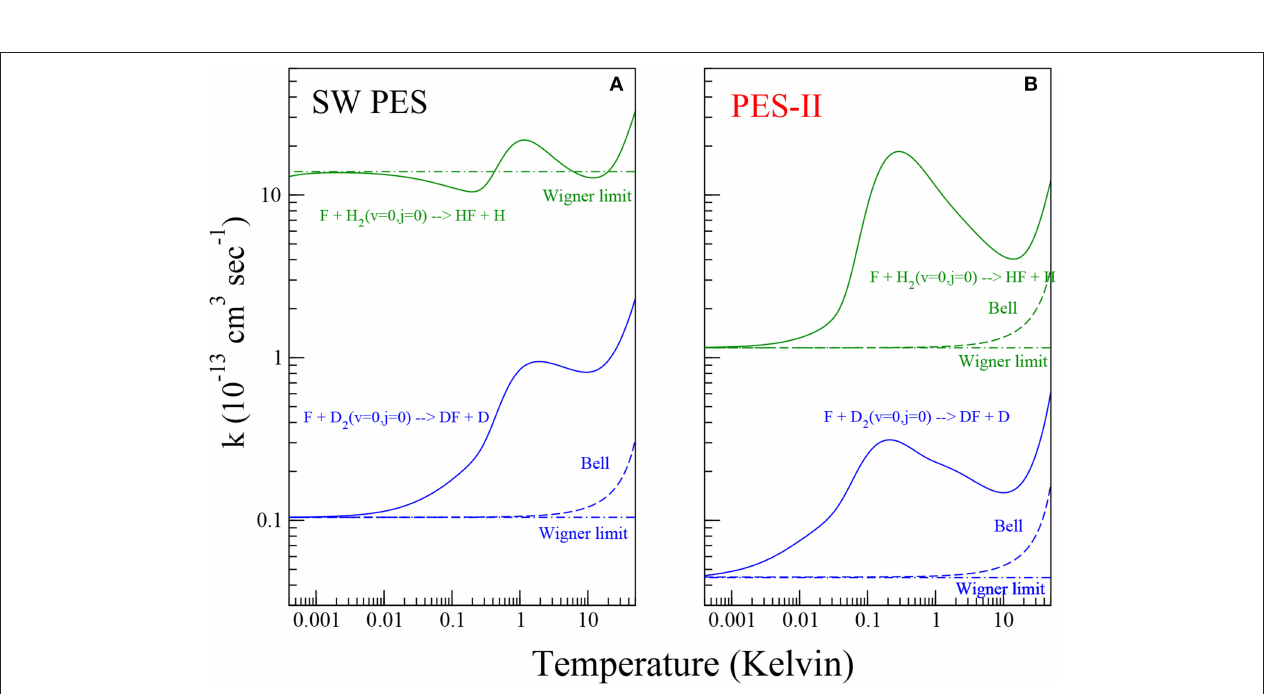
FIGURE 2 | Rate constants for the reaction of the F atom with H 2 (green color) and D 2 (blue color) molecules on the SW PES [panel (A) ] and PES-II [panel (B) ]. The solid lines show the numerically exact results obtained by rigorous quantum reactive scattering calculations (Equation 7). The dashed lines depict the Bell approximation (Equation 11). The dot-dashed lines show the Wigner limit (Equation